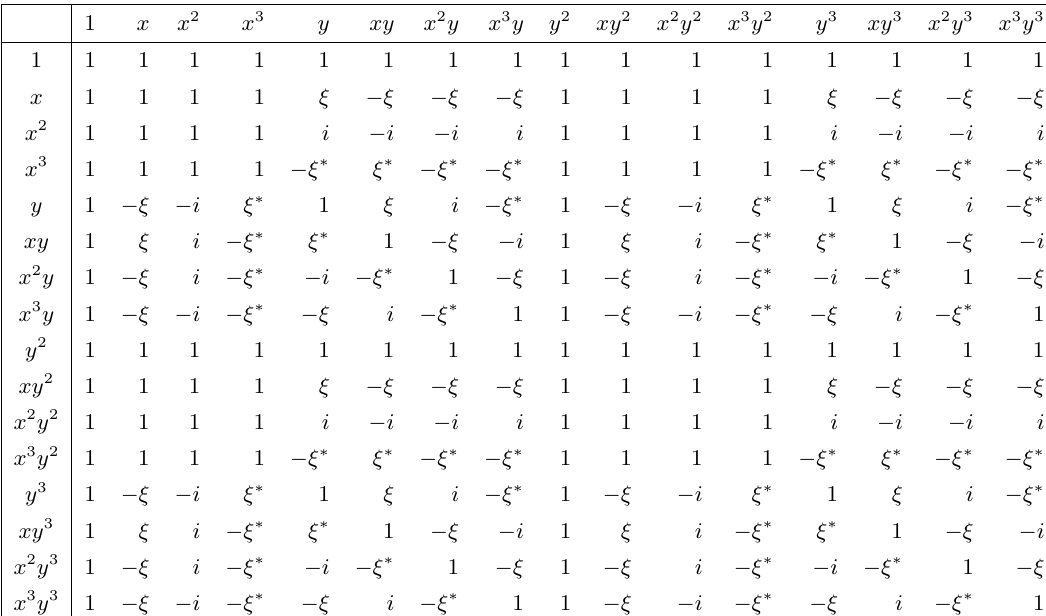
Table 9 . Table of values of the nontrivial cocycle in H 2 ( Z 4 o Z 4 , U(1)) . Here, ξ ≡ exp(3 πi/ 4) = √ ( − 1 + i ) / 2 .